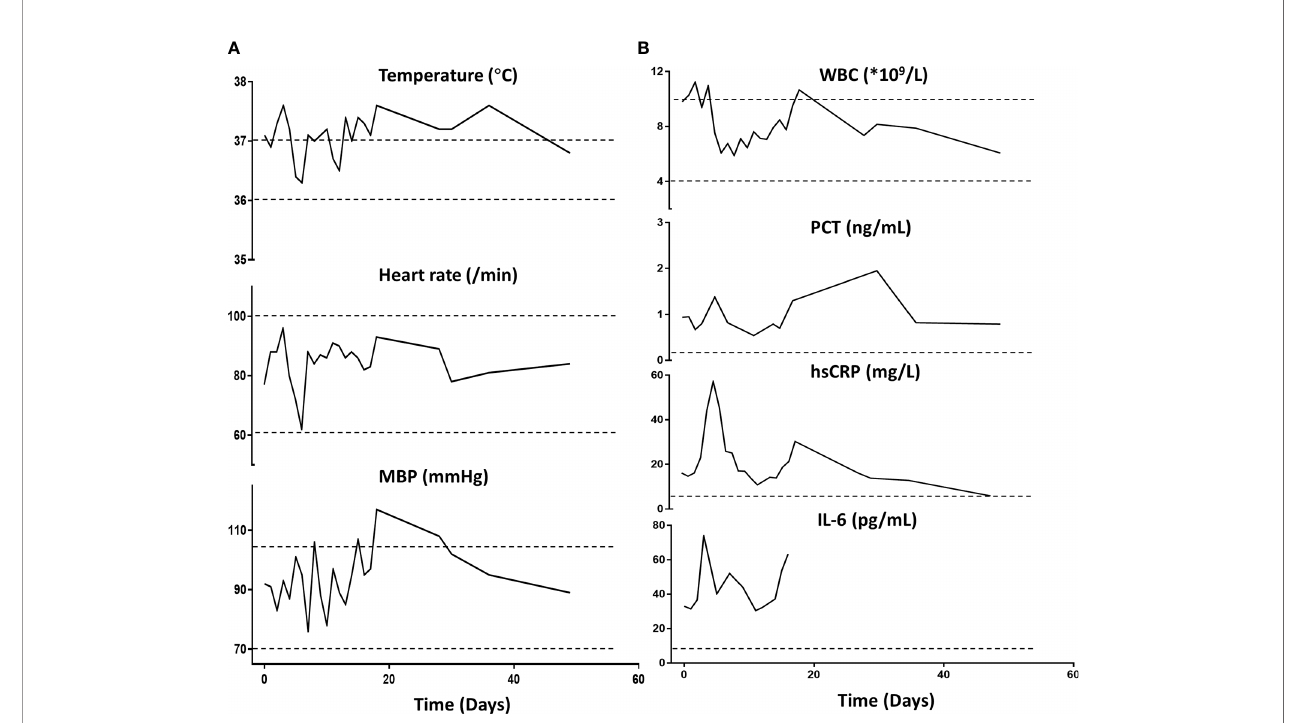
FIGURE 3 | Patient ’ s clinical examination (A) and in fl ammatory factor pro fi le (B) . No major alterations were observed (day 0 indicates the time when phage therapy was initiated). MBP, Mean blood pressure; WBC, white blood cells; PCT, procalcitonin; hs-CRP, high-sensitivity C-reactive protein. Normal ranges are presented between dotted lines in temperature, heart rate, MBP, and WBC; normal ranges are below the dotted line for PCT, hsCRP, and